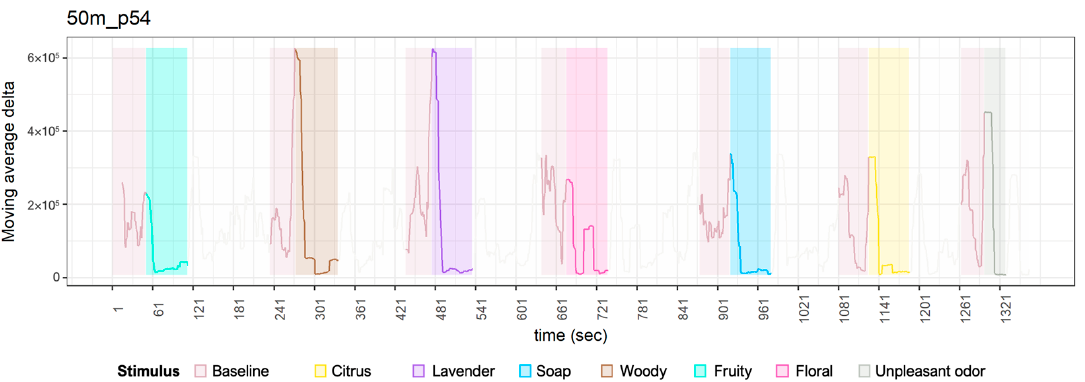
Figure A1. Time series plot of delta wave of one participant from the male 20s–30s group. The lines indicate the moving average values of delta wave Y-axis) against the time (X-axis) from the beginning to the end of the experiment. Different colors indicates different experiment conditions (olfactory stimuli or resting as baseline).